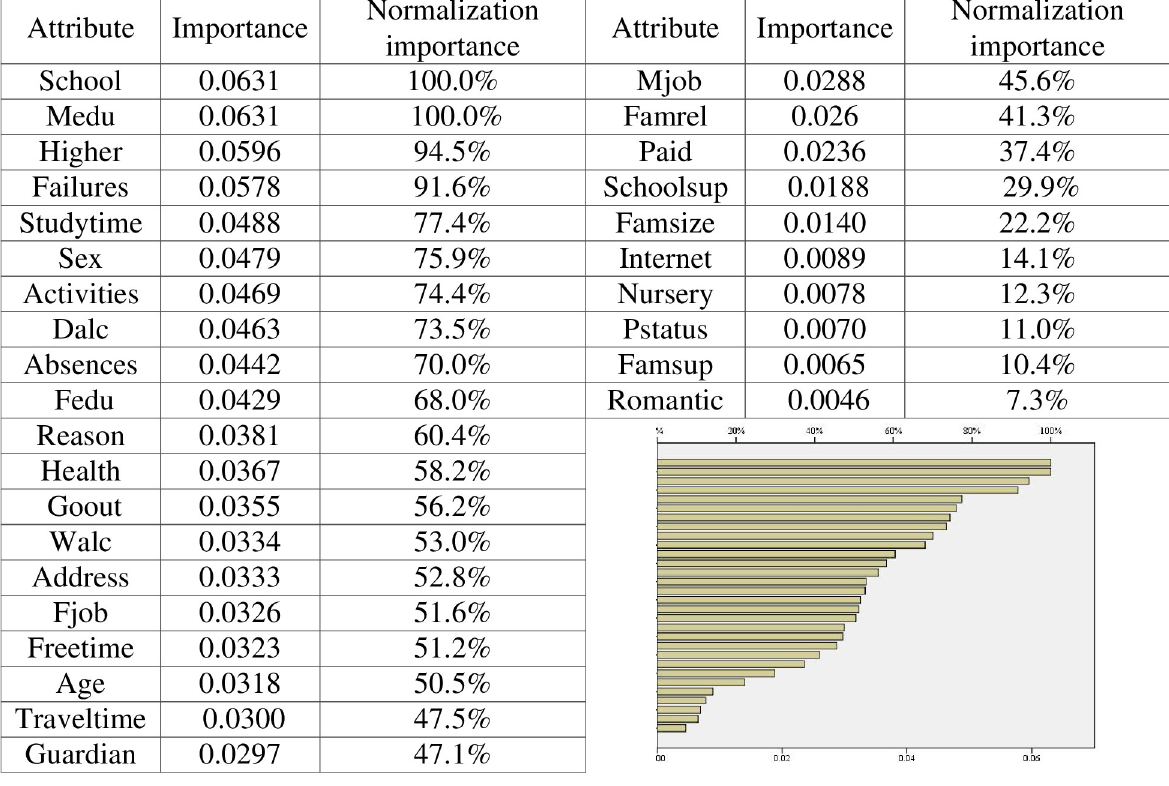
Fig 7. Results of variable